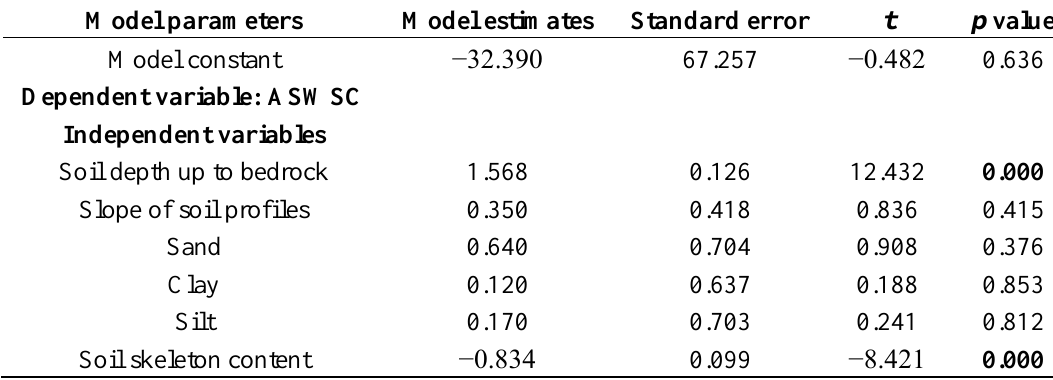
Table 1. Results from linear regression analysis regarding the influence of soil physical properties and slope on available water storage capacity (ASWSC) (Model R 2 = 0.961, F = 68.269, df = 6, p < 0.0001).